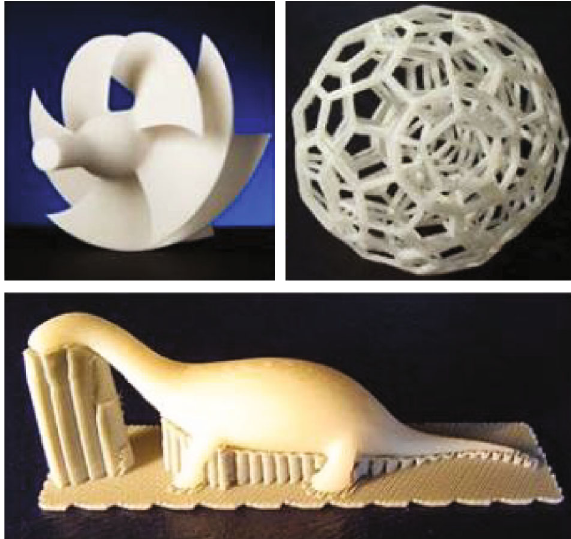
Figure 2: Typical components developed using AM technology [3].